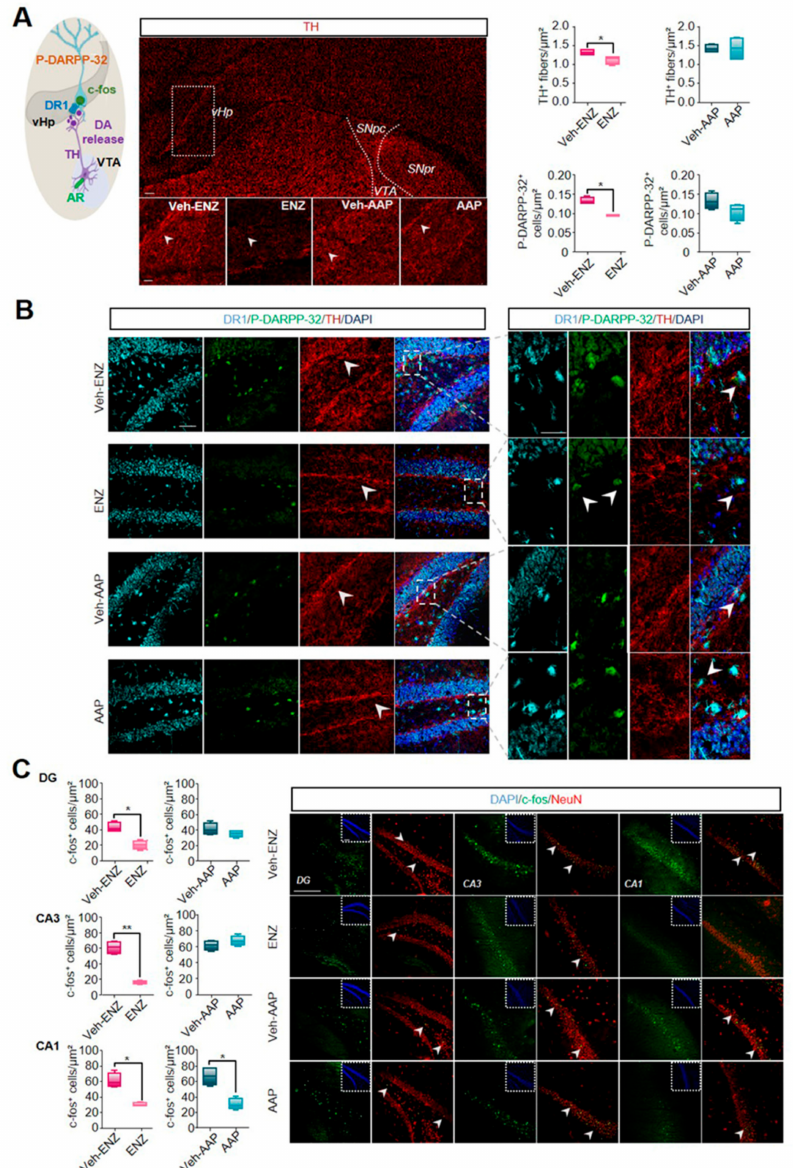
Figure 5. ENZ modulates midbrain dopaminergic release to ventral hippocampus. Note. ( A ) Schematic of dopaminergic projections to ventral hippocampus (vHp) from VTA and conse- quent neuronal activation. Immunofluorescence of TH + -DA projections likely arising from VTA and projecting to vHp of ENZ-, AAP- and vehicle-treated mice (seen on magnification of squared areas). Scale bar: 100 µ m. On the right, Whisker boxes represent the intensity of TH + fibers and number of P-DARPP-32 + cells in the vHp (right panel) of ENZ- and AAP-treated mice compared with respective vehicles. Statistical quantifications were performed using Mann–Whitney test. Data are represented as box and whiskers of mean ± SEM ( n = 4 mice), * p < 0.05. Scale bar: 100 µ m. ( B ) Representative images of P-DARPP-32 + —(green), DR1 + —(cyan), TH + —(red) positive fibers and DAPI (blue) immunoreactivities in vHp of ENZ-, AAP- and Vehicle-treated mice. Scale bar: 25 µ m and 100 µ m. ( C ) Representative example of the immediate early gene (c-fos, green) and NeuN (red) immunoreactivities in the DG, CA3 and CA1 regions of vHp of ENZ-, AAP- and vehicle-treated mice. The boxed areas show DAPI (blue) immunoreactivity. On the left, whisker boxes represent the number of c-fos + cells in DG, CA3 and CA1 hippocampal areas of ENZ- and AAP-treated mice compared with respective vehicles. Statistical quantifications were performed using Mann–Whitney test. Data are represented as box and whiskers and mean ± SEM ( n = 4 mice), * p < 0.05, ** p ≤